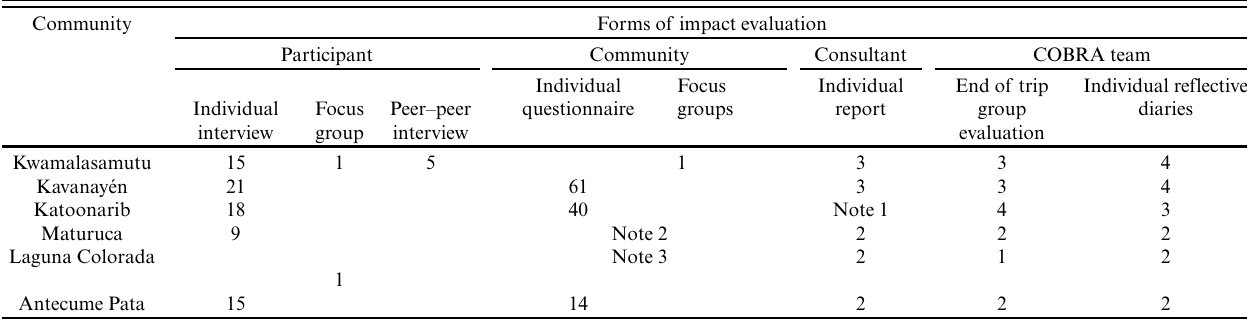
Table 3 . Types of monitoring and evaluation undertaken in each community.